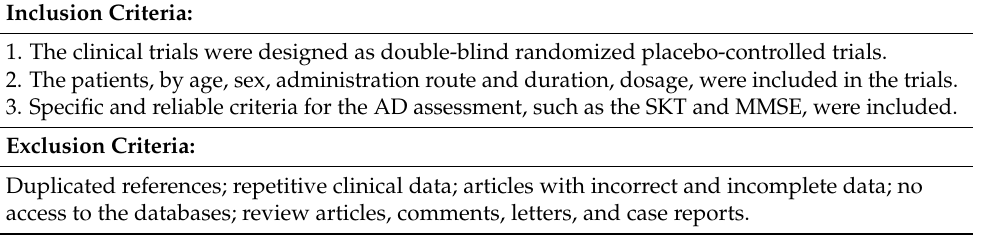
Table 2. Inclusion and exclusion criteria for selecting clinical